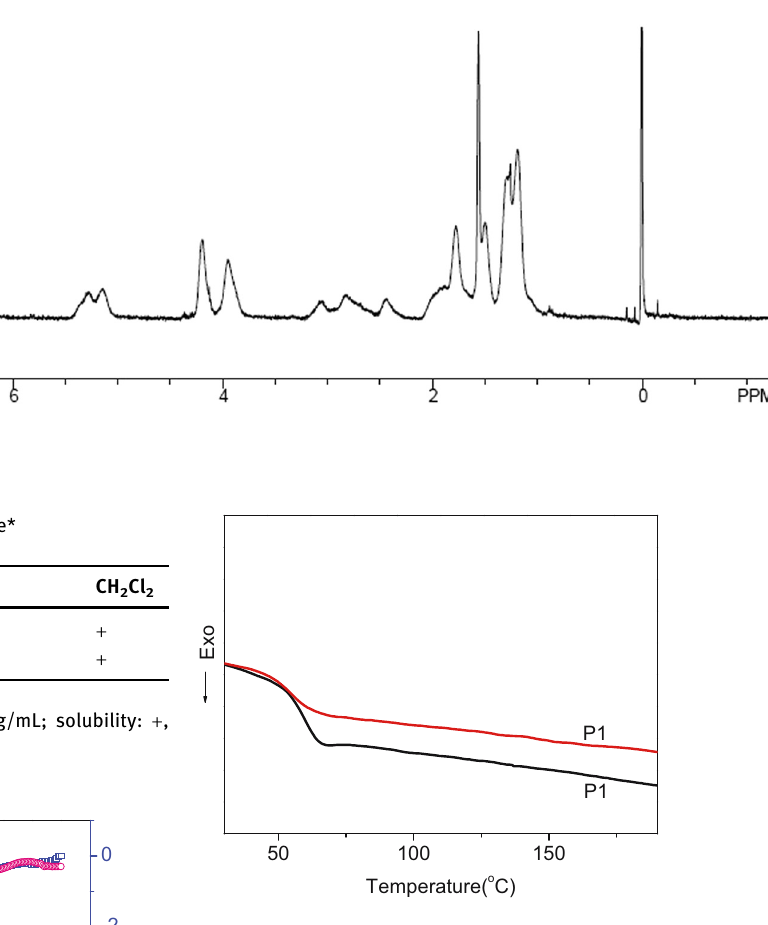
Figure 3: DSC curves of polymers P1 and P2